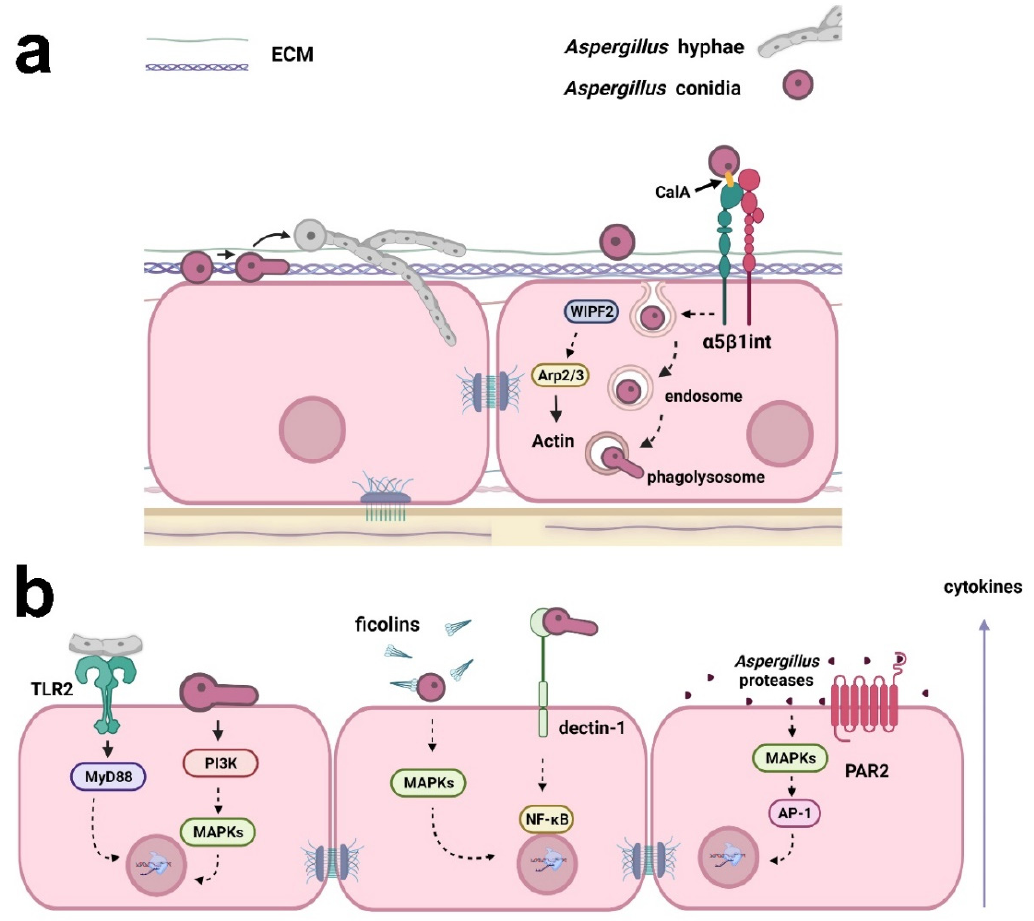
Figure 1. Examples of the responses of respiratory epithelial cells to Aspergillus infection. ( a ) Aspergillus conidia can bind to extracellular matrix (ECM) proteins and epithelial cell surface. Conidia may germinate on the surface of epithelial cells, and the resulting hyphae can actively invade the cells. Conidia internalization may occur through fungal CalA interaction with host α 5 β 1 integrin and WIPF2, Arp2/3, and actin reorganization. Conidia can also be trafficked in the endosomal system and germinate in phagolysosomes, reentering the extracellular space. ( b ) Cytokine secretion by epithelial cells may be a result of (i) the interaction of Aspergillus hyphae with TLR2, activating MyD88; (ii) the activation of PI3K and MAPKs by germinating conidia; (iii) the opsonization of Aspergillus conidia by ficolins and MAPK activation; (iv) interaction with dectin-1 and the activation of NF- κ B; and (v) activation of MAPKs and the transcription factor AP-1 by Aspergillus proteases. Aspergillus proteases can also activate PAR2, inducing cytokine production. Created with Biorender.com.